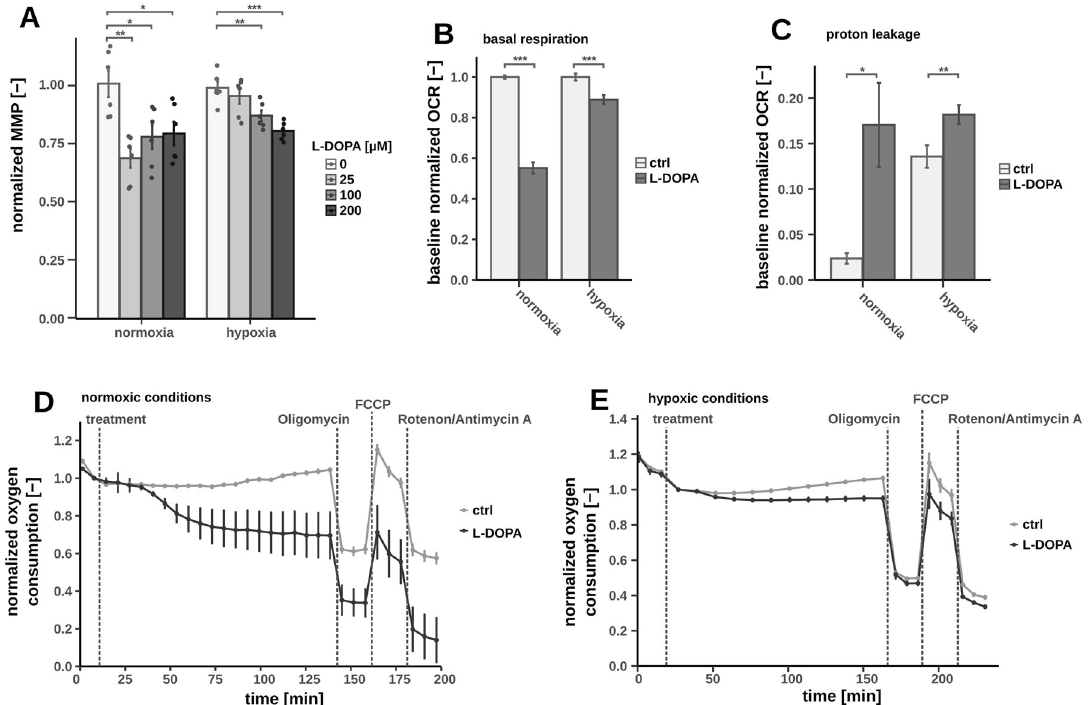
Fig. 3 Mitochondrial membrane potential (MMP) and oxygen uptake under normoxic and hypoxic conditions after 2 h of L -DOPA treatment on fully differentiated LUHMES cells, signi fi cance level were calculated using Welch ’ s t -test (* p -value < 0.05, ** p -value < 0.01, *** p -value < 0.001). A MMP with n = 6; B Calculated basal respiration after L -DOPA treatment ( n = 13); C Calculated proton leak after L -DOPA treatment (normoxia: n = 4, hypoxia: n = 13); OCR over time under normoxic ( D ) or hypoxic conditions ( E ) after injections with L -DOPA, Oligomycine (Olig), FCCP and Rotenone/Antimycine A (Rot-AA) ( D : n = 4; E : n =